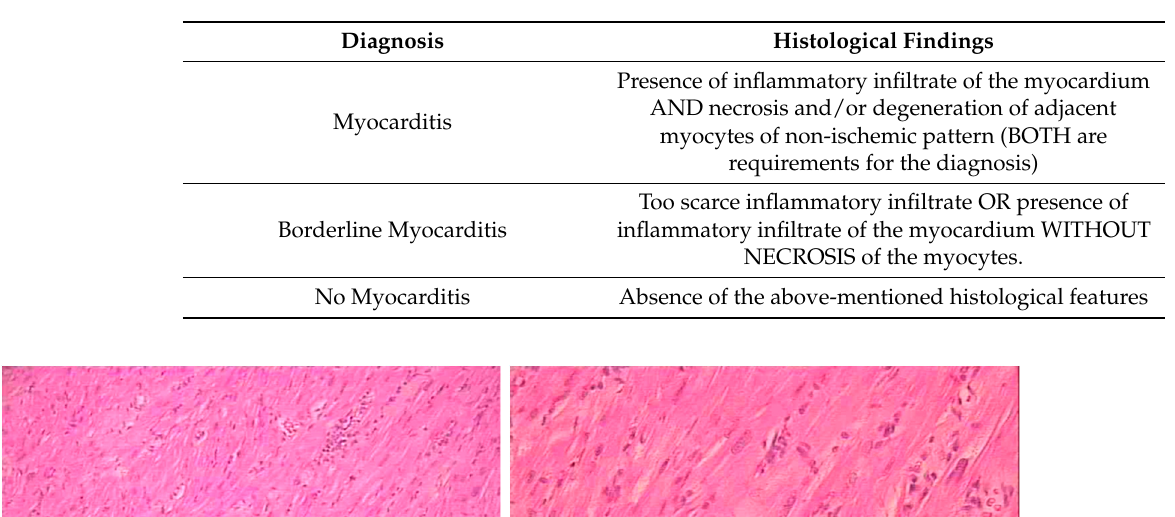
Table 1. The Dallas Criteria.